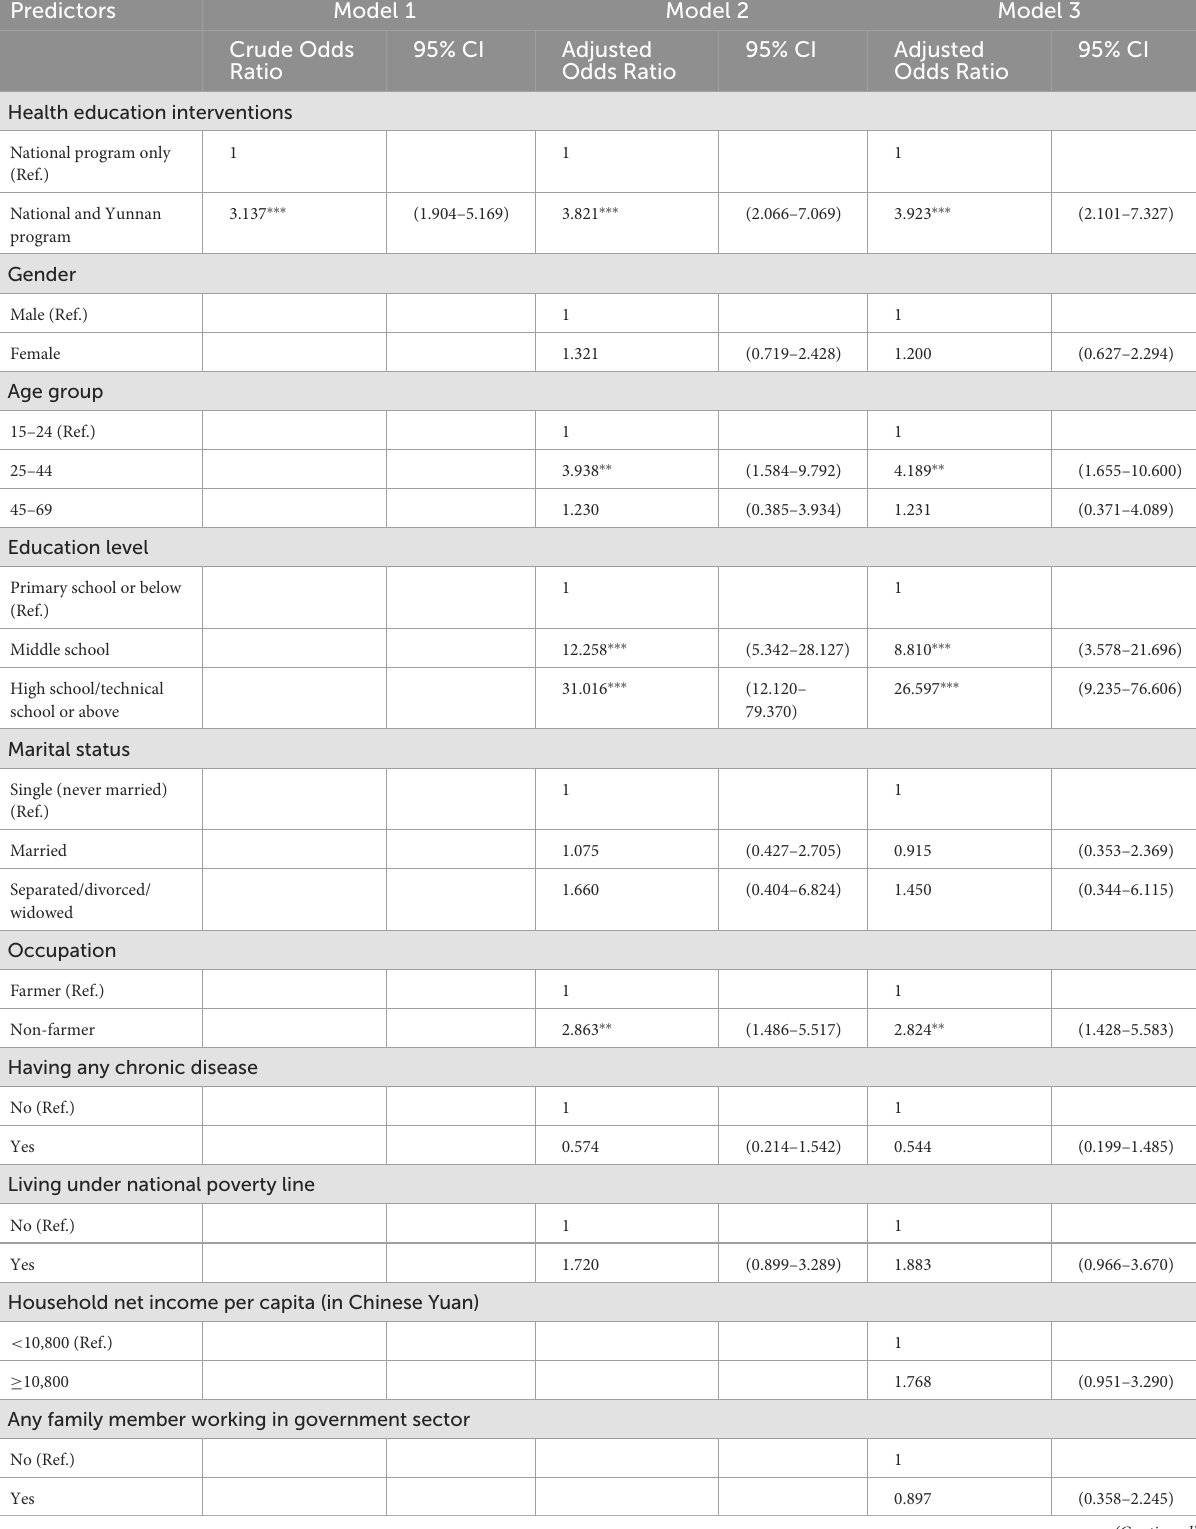
TABLE 4 The effect of program intervention on health literacy among residents in severely impoverished counties in Southwest China–results from logistic